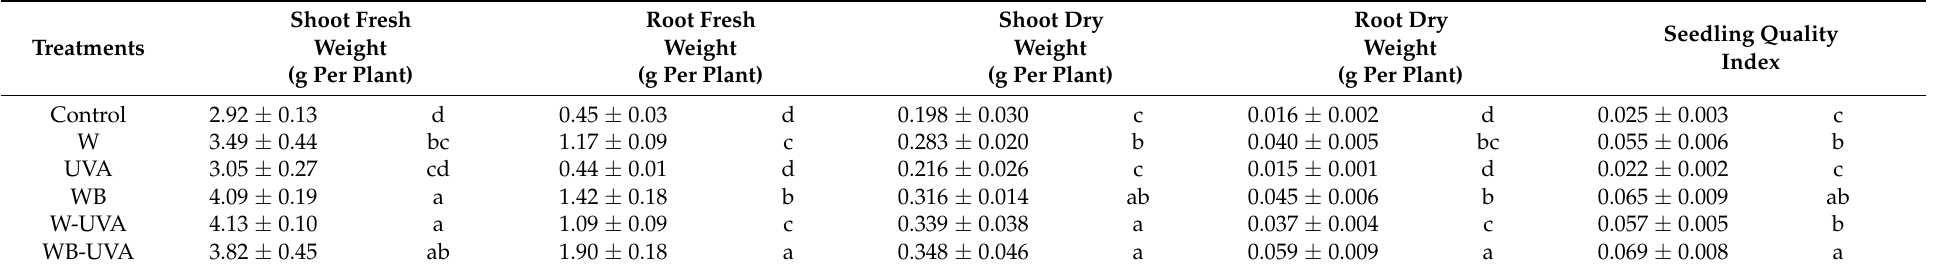
Table 3. Fresh and dry weights of greenhouse-grown cucumber seedlings cultivated under supplementary light provided by white (W), UV-A light-emitting diodes (LEDs), and various combinations of W, blue (B), and UV-A LEDs; cucumber seedlings grown with natural light only were used as